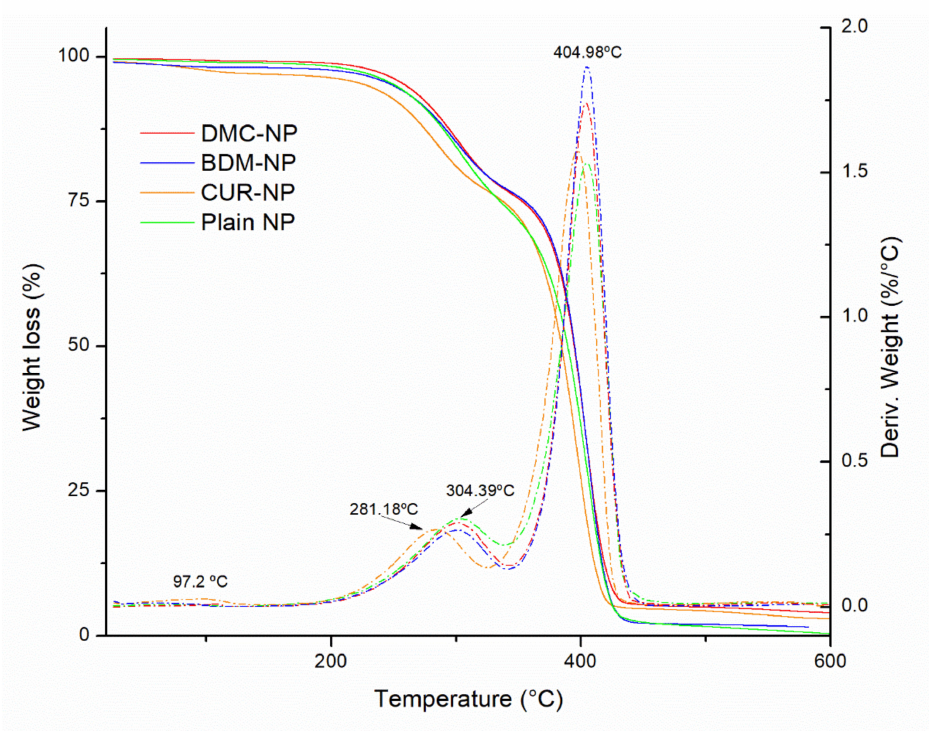
Figure 5. TGA curves of plain NP, CUR-NP, DMC-NP, and BDM-NP. Dashed and dotted lines represent the derivative of % weight loss as a function of